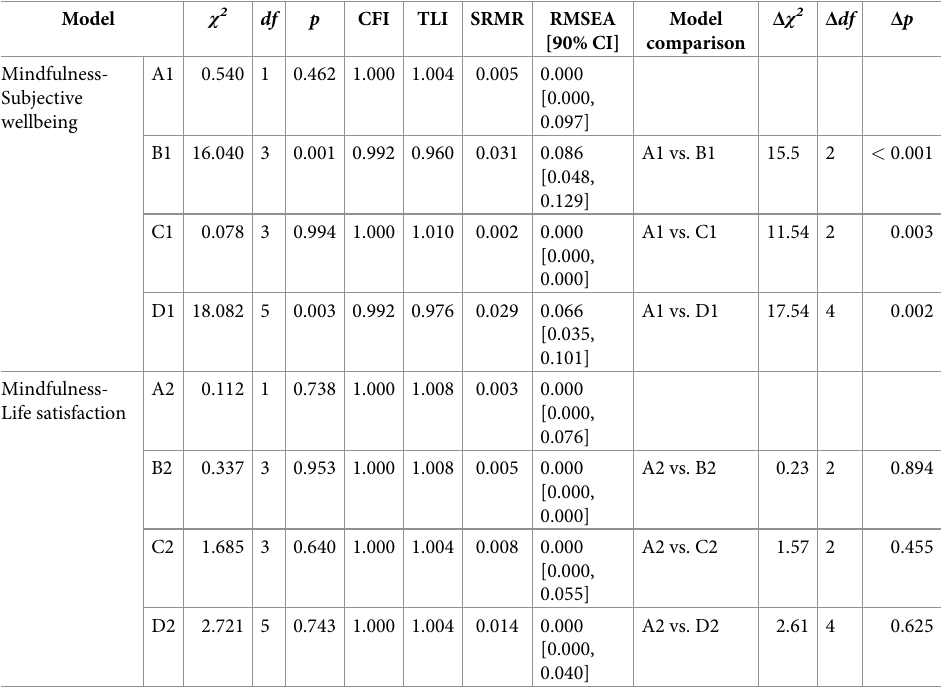
Table 9. Model comparisons for different constraint conditions in the exploratory analysis.